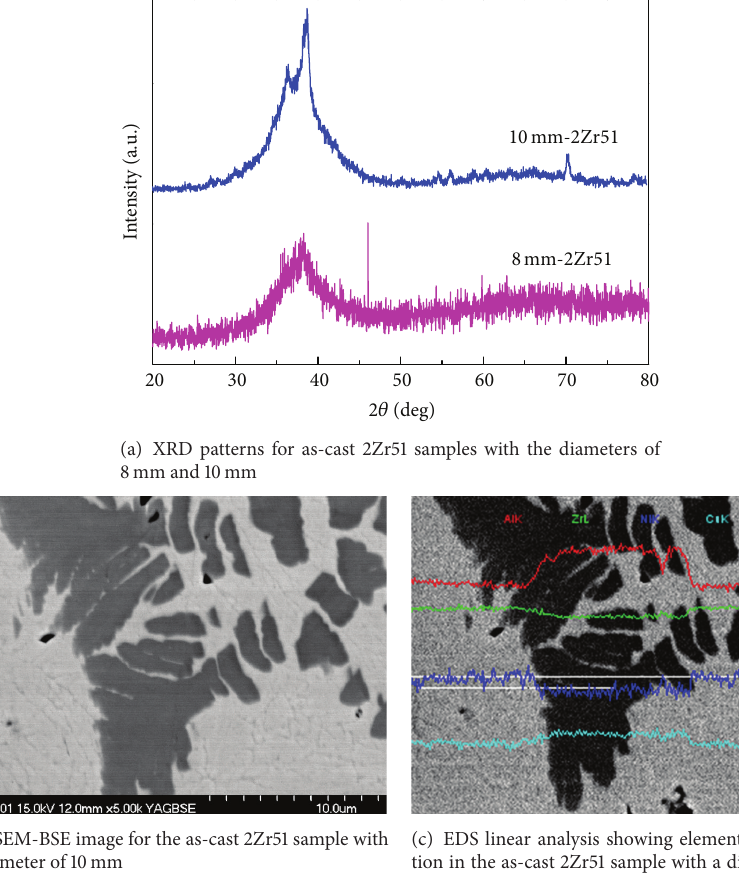
Figure 2: The XRD and SEM patterns for as-cast 2Zr51 samples in different